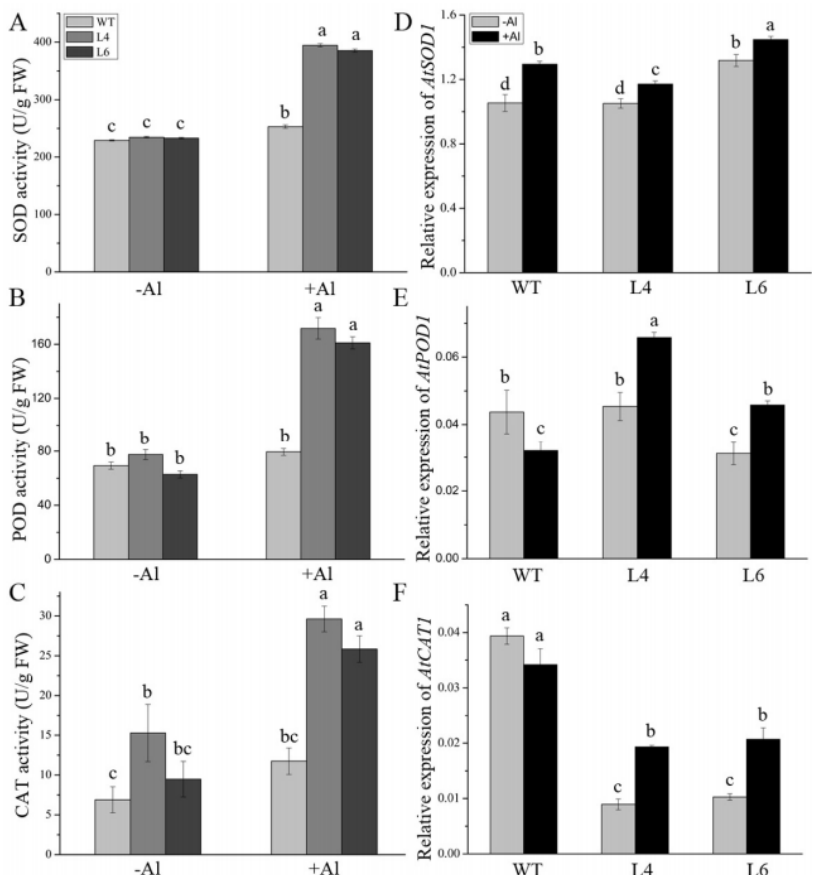
Figure 10. Effect of Al on the activities and transcripts’ level of antioxidant enzymes. Two–week–old seedlings were treated with 60 µ M AlCl 3 for 12 h and the total activity of ( A ) SOD; ( B ) POD, and ( C ) CAT and transcripts’ level of ( D ) AtSOD1 ; ( E ) AtPOD1 , and ( F ) AtCAT1 were analyzed. Relative gene expression was normalized to the AtACT2 . Values are means ± SD ( n = 20). Different letters indicate significant differences ( p < 0.05) (Tukey’s